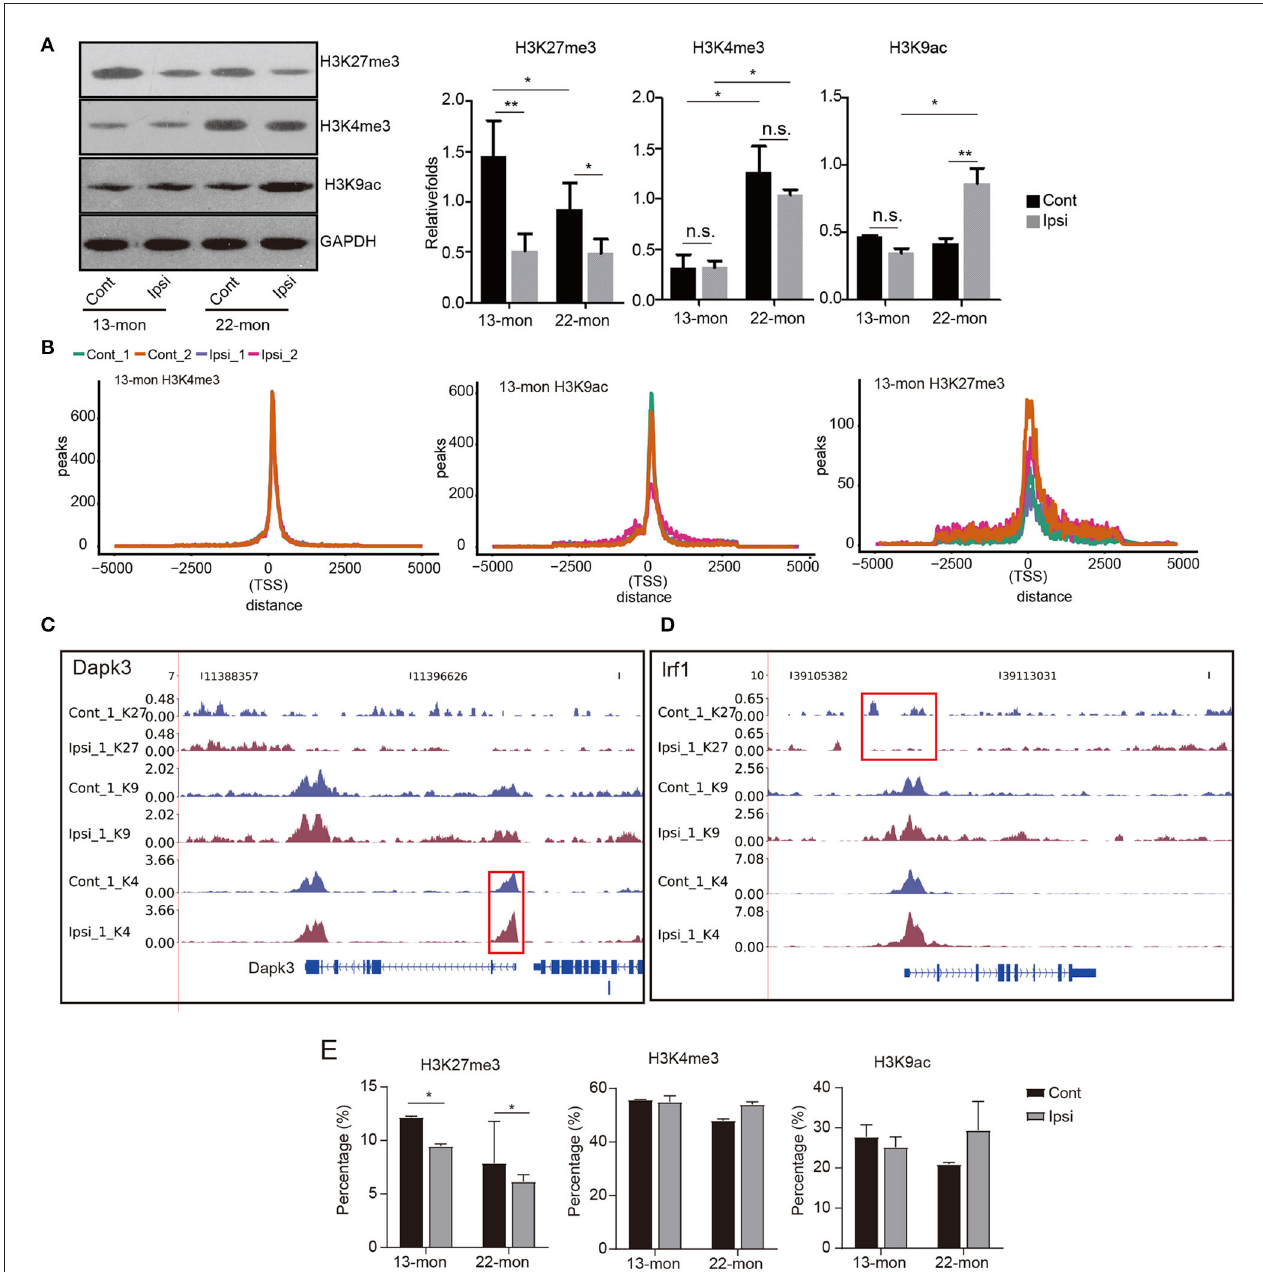
FIGURE 3 | Global histone mark profile assessment reveals their distribution change in response to ICH treatment. (A) Western blotting and quantitative analysis of H3K27me3, H3K4me3, and H3K9ac in the ipsilateral and contralateral brain tissues of 13- and 22-month-old rats 3 days after ICH ( n = 3). The bar graphs show the mean ± SEM. (B) Line plot shows the cumulative distribution of all uniquely mapped reads located within 5kb around the transcription start sites (TSSs) of the three histone marks. ChIP-seq samples of Ipsi and control obtained from 13-month-old rats are shown in the figure. (C,D) Read density plot shows the distribution of three histone mark densities around the selected genes ( Dapk3 , Irf1 , and Il1b ). Gene structures are shown on the bottom track. ChIP-seq samples (the first replicate) of Ipsi and control from 13-month-old rats are shown in the figure. (E) Bar plot shows the percentage of peaks located within 2.5kb around the TSS of the three histone marks. The bar graphs show the mean ± SEM. p -value in this figure was determined by using the Student’s t- test. * p < 0.05 and ** p < 0.01, respectively.